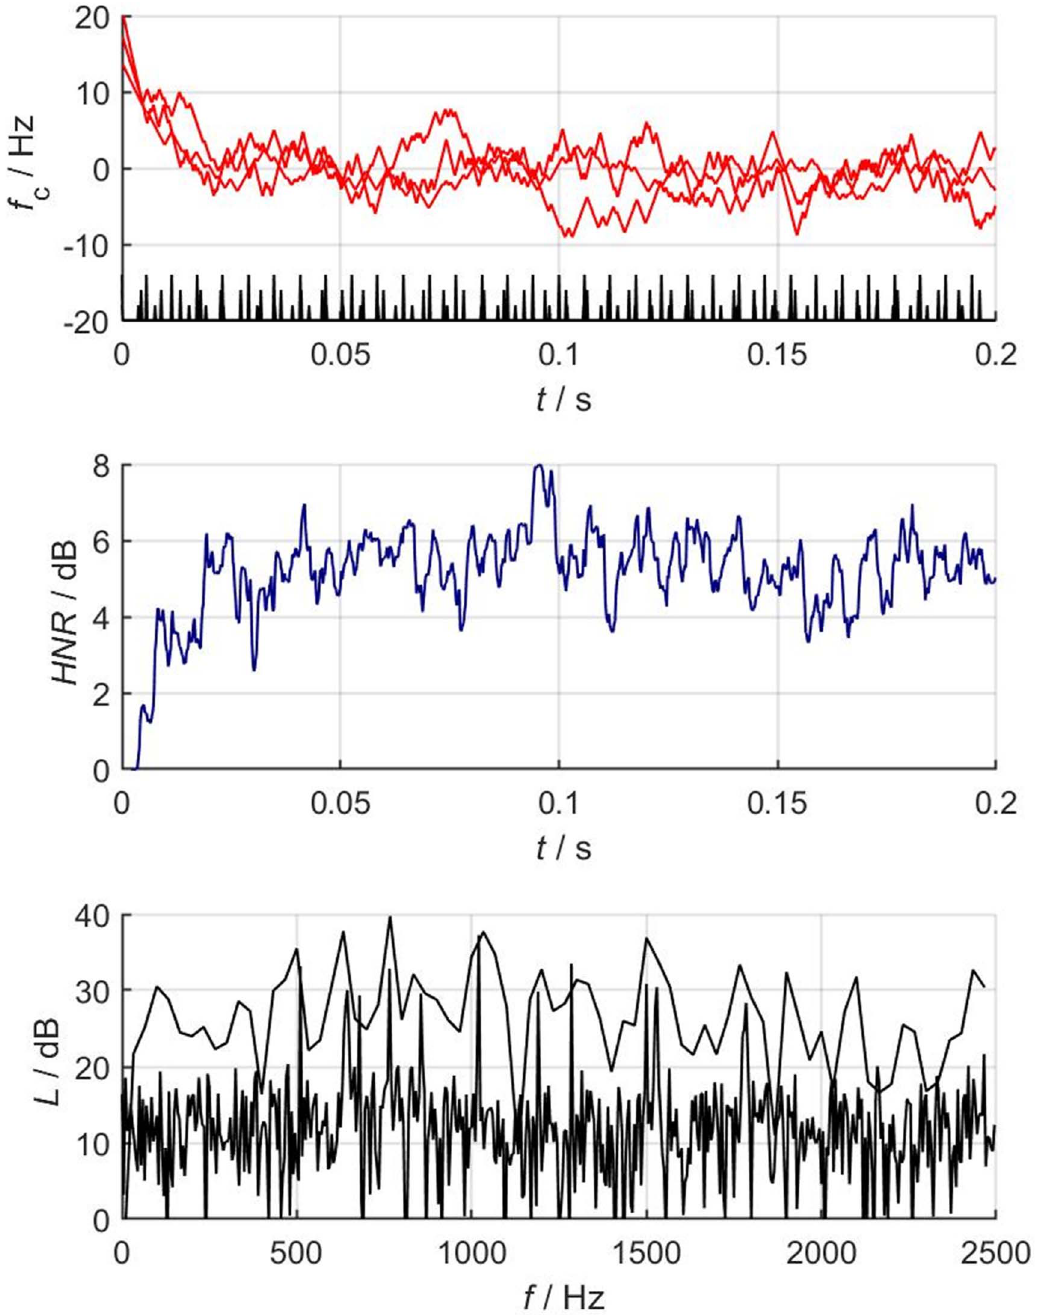
Figure 7. 3-tone major chord signal (simulation VI). The upper panel shows the oscillator frequency (i.e., fundamental frequency estimate) f c of three PM-HLL instances as a function of time. Each instance targeted one of the tones by selecting the instance ’ s initial f c to be a semitone above the target ’ s f 0 , i.e., f 0 lies at the upper edge of the instance ’ s catch range. In the plot, each instance ’ s f c